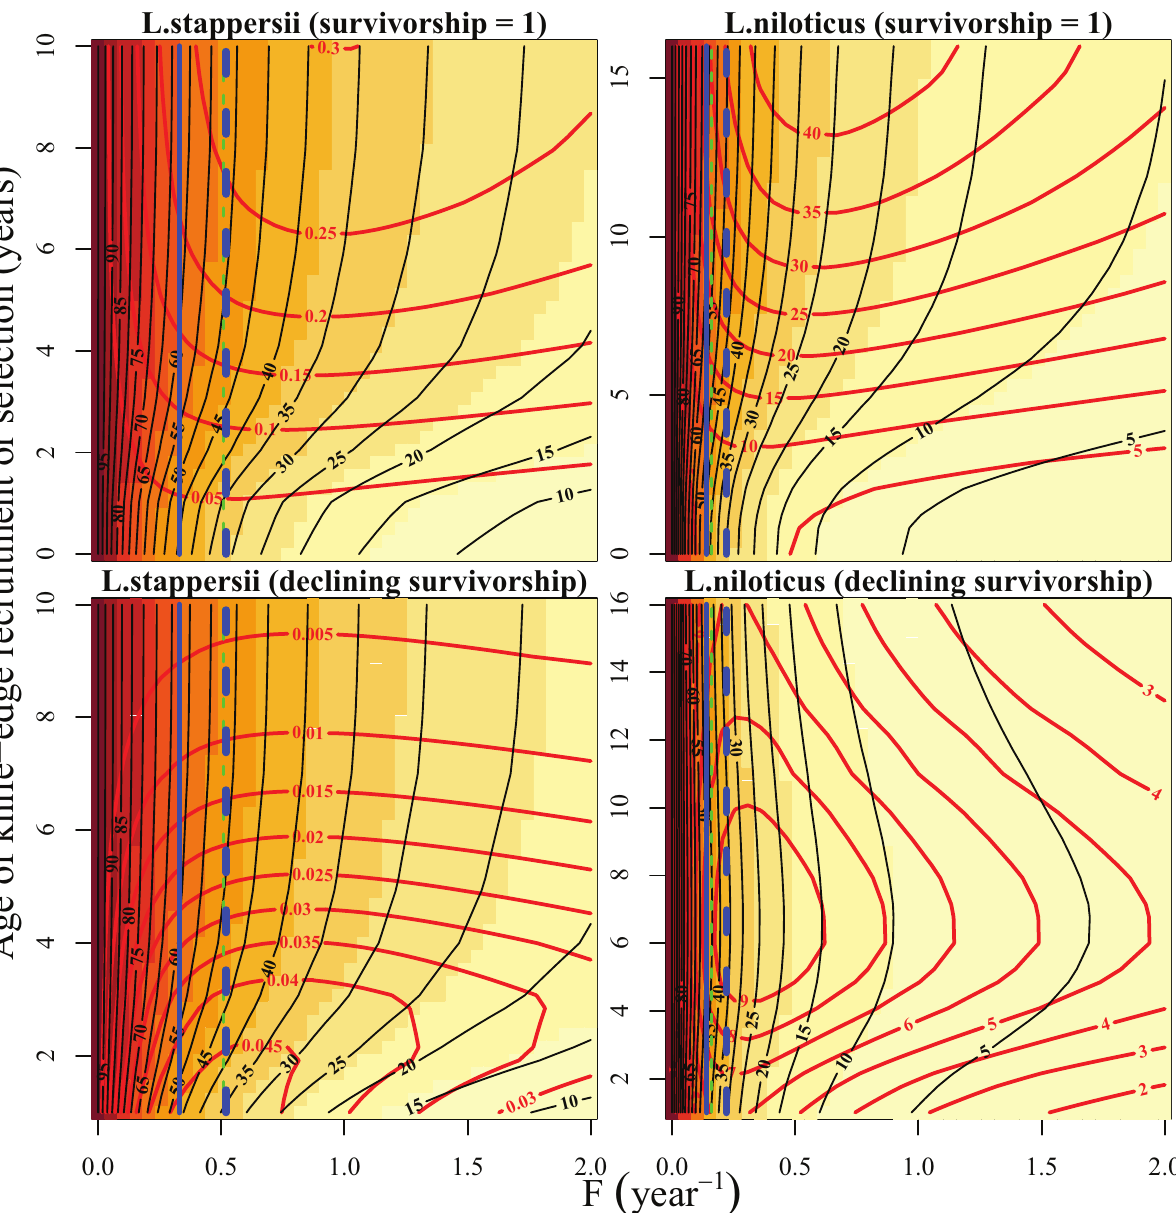
Fig. 6. Simultaneous presentation of trade-offs between mean CYPR (red contours and fi gures) and mean CSPR (black contours and fi gures) as a function of fi shing mortality ( F ) and the age of knife-edge recruitment or the age of knife-edge selection for L. stappersii in Lake Tanganyika (left panels) and L. niloticus in Lake Victoria (right panels), considering that the fi sheries operate at mean F CYPR (vertical, blue solid dash line), mean F 0.1 (vertical, blue solid line), or mean F 35%CSPR for L. stappersii and mean F 40%CSPR for L. niloticus (vertical and light green dash line) as estimated from baseline analyses (Tab.